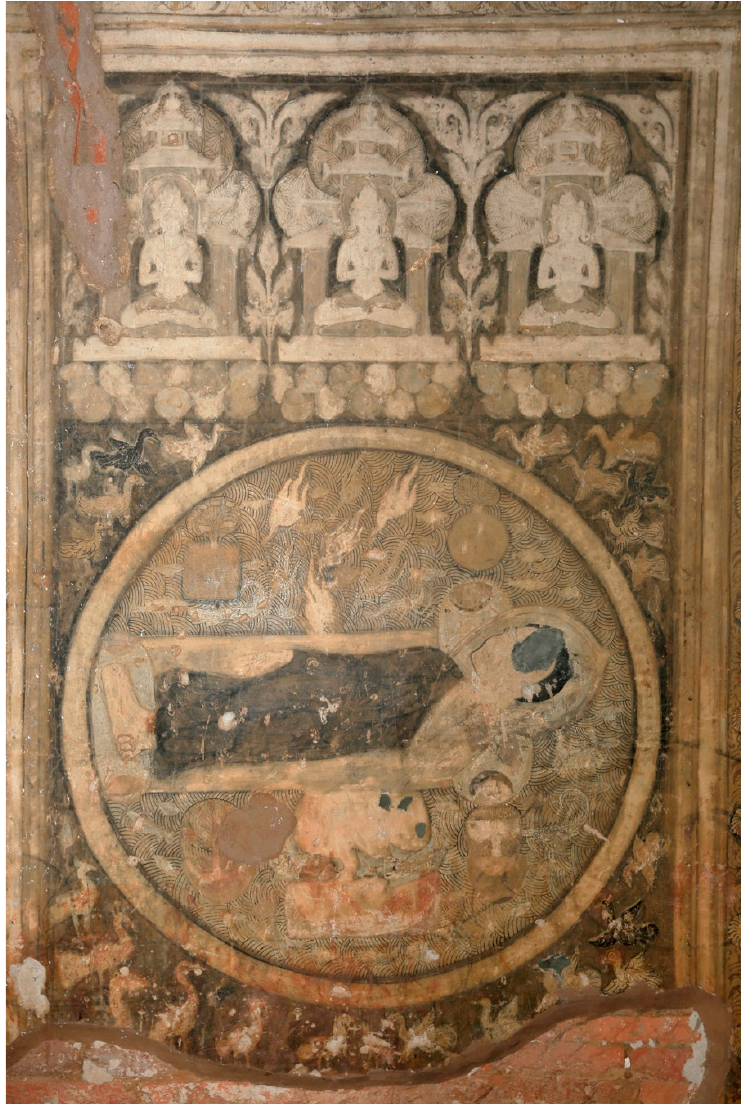
Figure 15. Pagan, 13th Century, endowment 585. The bodhisatta’s dreams on the Night of Awakening, linked to three heavenly mansions providing corroboration for the dreams’ interpretation.